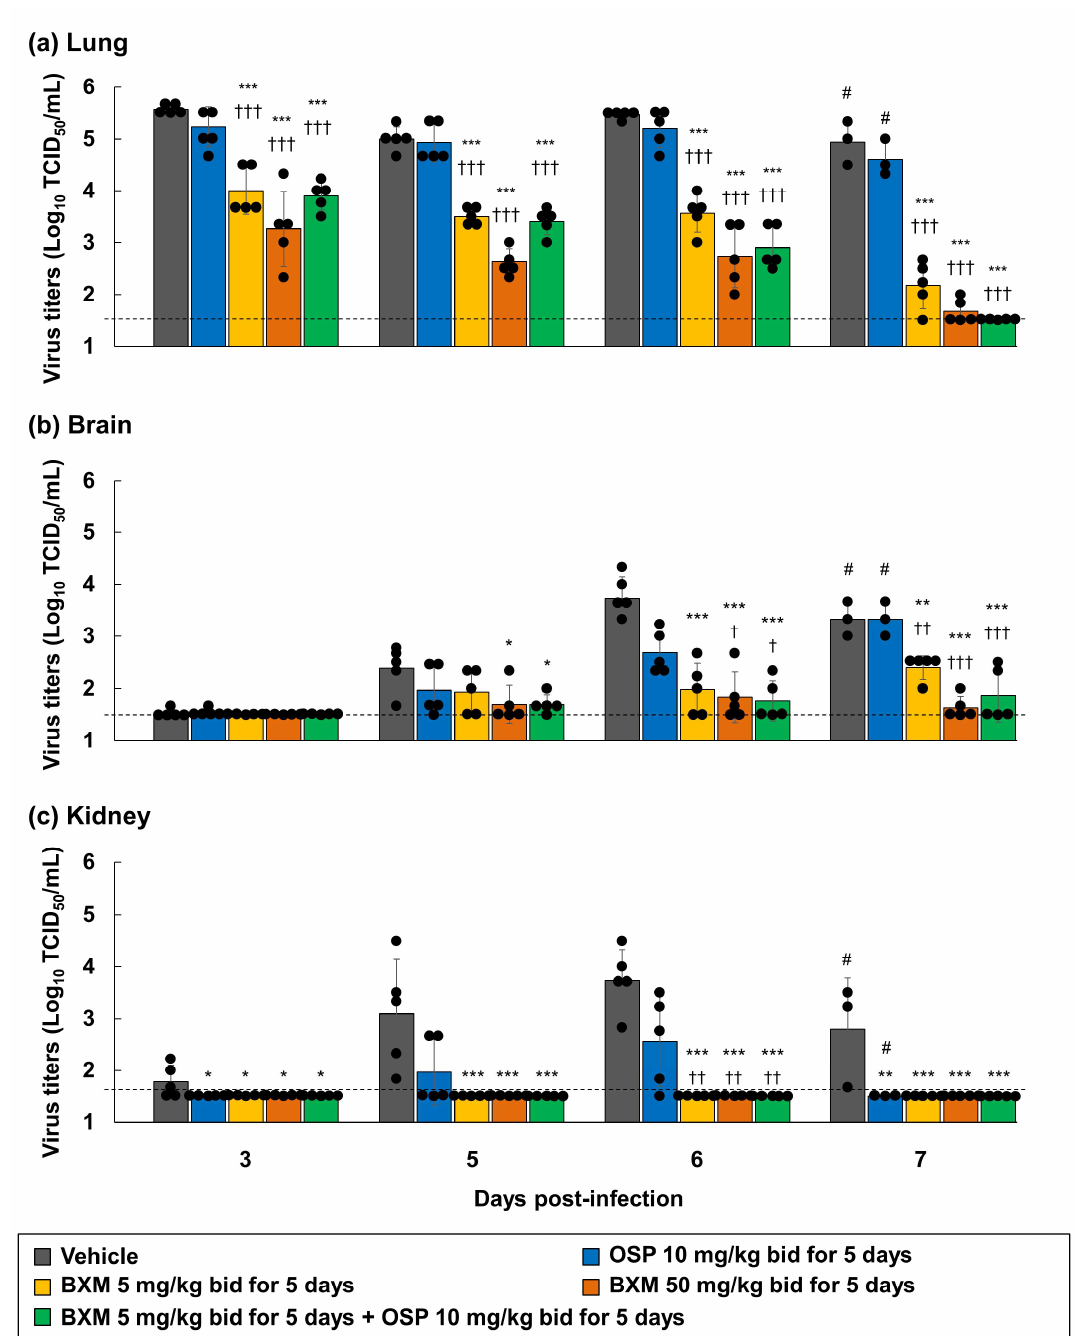
Figure 6. Inhibitory effects of delayed treatment of BXM, OSP, or their combination on the viral titers in the lungs, brains, and kidneys of mice infected with H5N1 HPAIV. The mice were intranasally infected with 75 TCID 50 /mouse (31.3 MLD 50 ) of the A/Hong Kong/483/1997 (H5N1) virus, and treatment was started 48 h after viral inoculation. Viral titers (TCID 50 ) in the ( a ) lungs, ( b ) brains, and ( c ) kidneys of mice at 3, 5, 6, and 7 dpi measured in MDCK cells ( n = 5/group). The lower limit of quantification of the viral titer is indicated using a dotted line (1.5 log 10 TCID 50 /mL). Dunnett’s multiple-comparison test was conducted for a statistical comparison between the viral titers in each organ group (* p < 0.05, ** p < 0.01, *** p < 0.001 compared with vehicle, † p < 0.05, †† p < 0.01, ††† p < 0.001 compared with OSP at 10 mg/kg twice daily). #, n = 3/group. Two of 5 mice in each group died at 7 dpi.